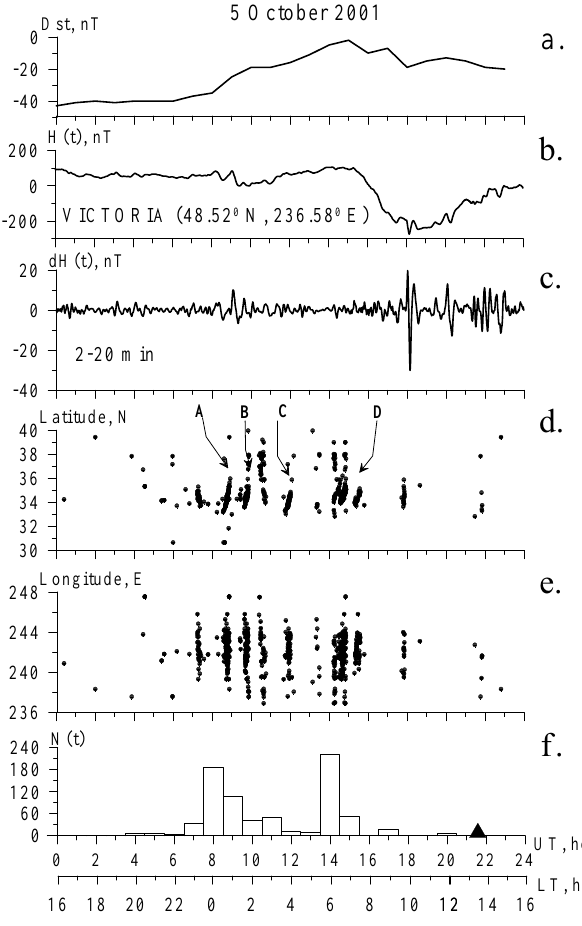
Fig. 5. Geomagnetic field D st -variations ( a ) 5 October 2001. H(t) - variations of the horizontal component of the geomagnetic field as recorded at station Victoria (236 . 58 ◦ E; 48 . 52 ◦ N) – (b) . dH(t) - variations, filtered from the series H(t) in the range of periods of 2–20min – (c) . (d) – the distribution of the values of the GPS sta- tion latitudes from time t min , corresponding to each of the TECS detected that day by all GPS stations of the California region that were used in the analysis (220 − 260 ◦ E; 28 − 42 ◦ E); (e) — same as in (d), but for the station longitudes and t min ; (f) – the distribution N(t) of the number of TECS that were detected that day at all GPS stations used in the analysis, with the rms above (cid:15) = 0 . 1 TECU . The letters A, B, C, and D in (d) label the TECS “traces” that are presented in Fig. 6 on a smaller time scale. The triangle in panel (f) designates the Titan-4 rocket launch time 21:21UT from the space- launch complex “Vandenberg” (239 . 5 ◦ E; 34 . 8 ◦